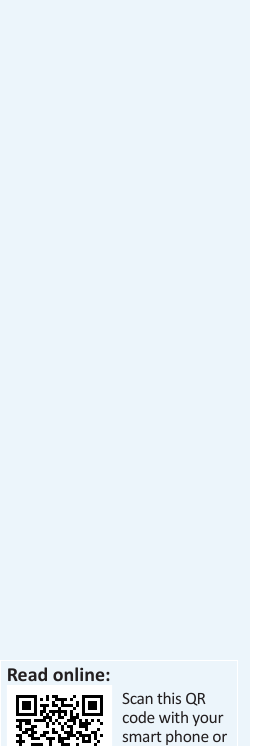
FIGURE 4: Coronal computerised tomography (CT) image of the anterior neck triangles demonstrating the multinodular